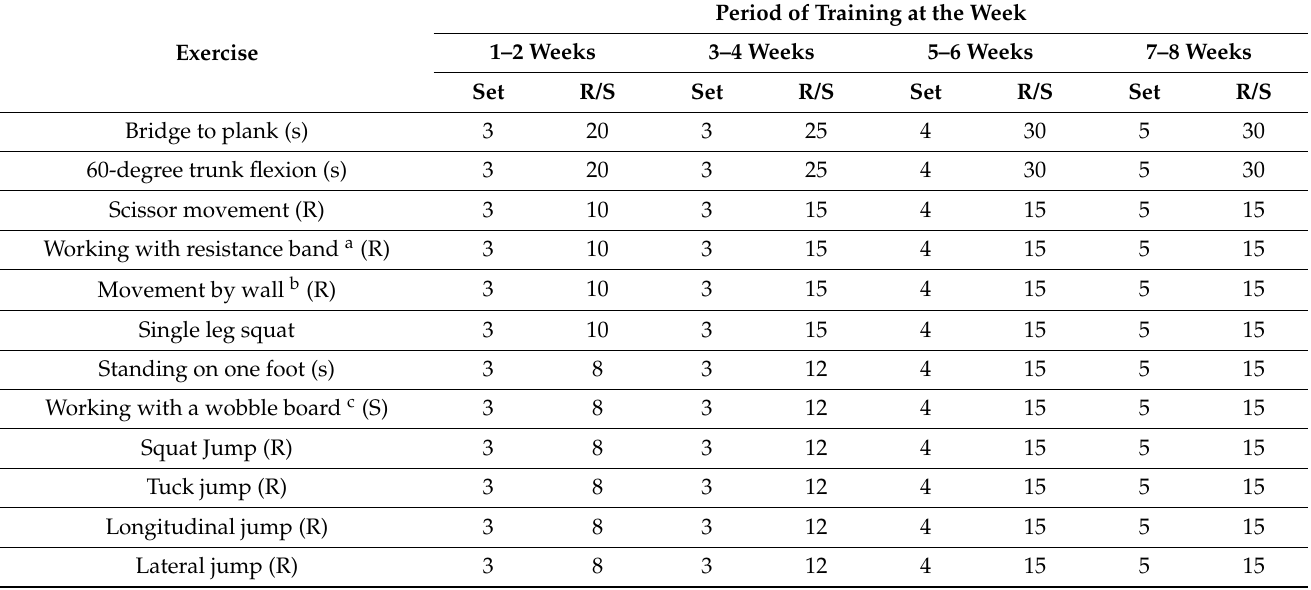
Table 1. Balance plus strength